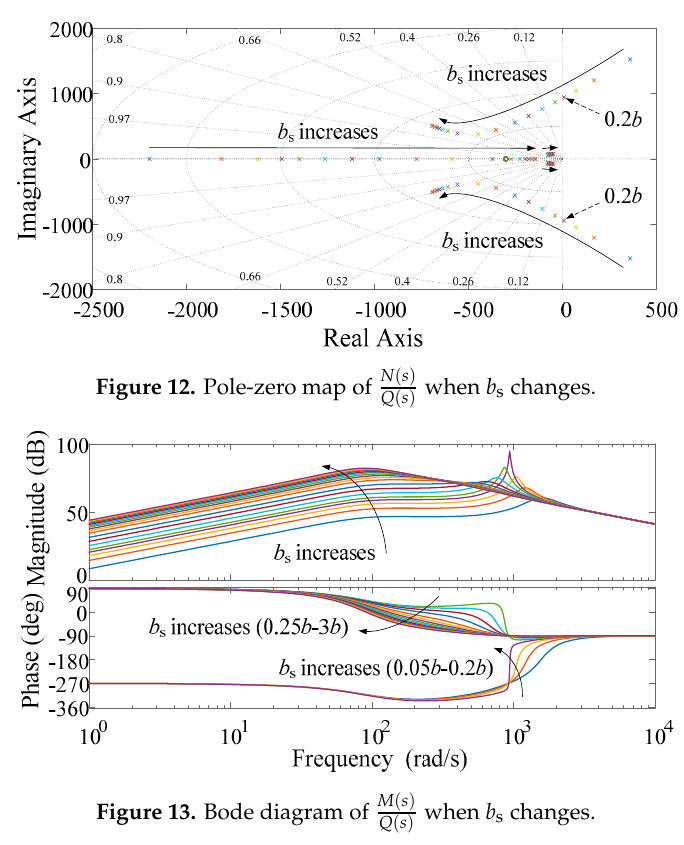
Figure 13. Bode diagram of M when s